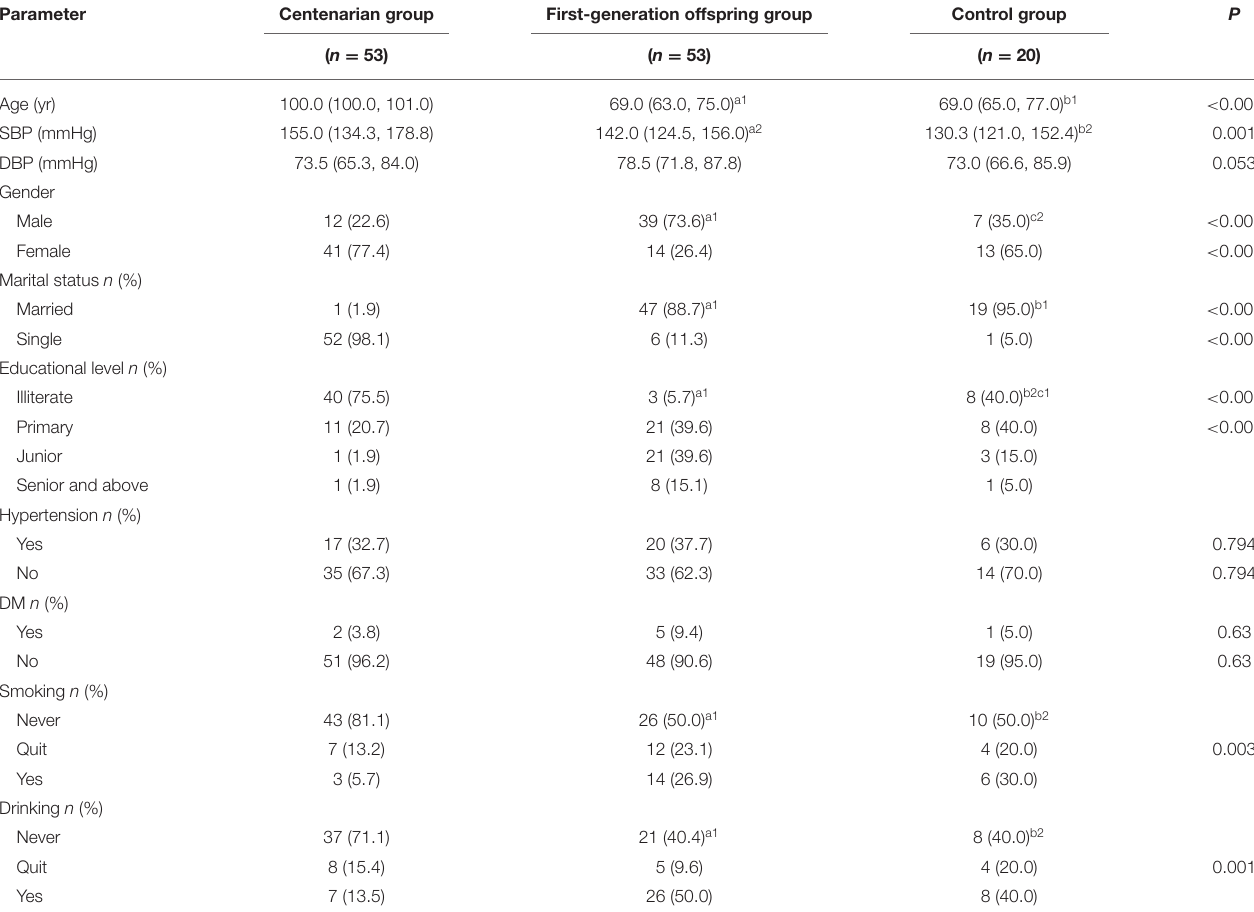
TABLE 1 | Clinical characteristics of the participants, according to group assignment. Parameter Centenarian group First-generation offspring group Control